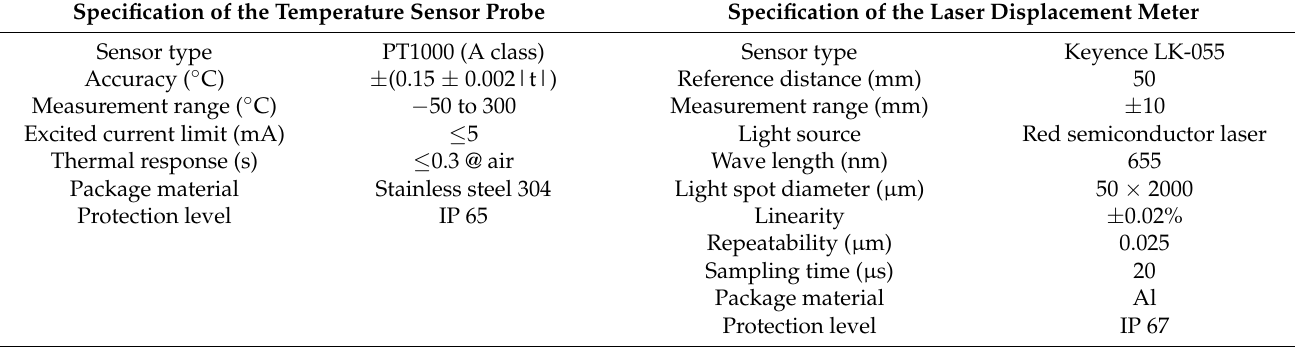
Table 1. The specifications of the